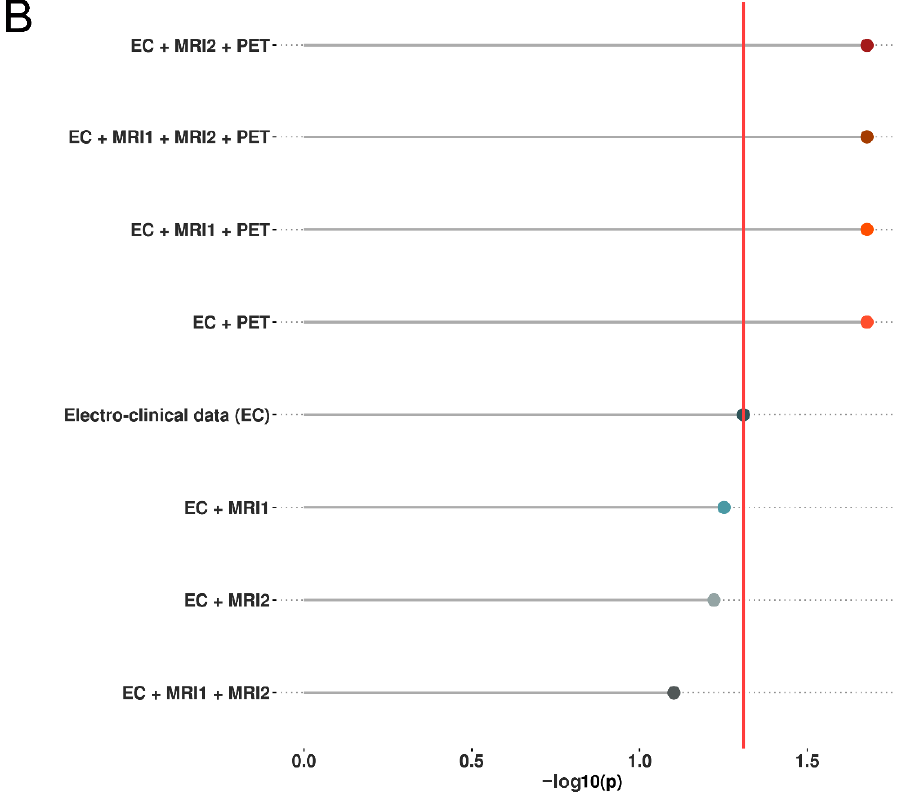
Figure 3. Clinical data concordance (CDC) of “Grouping Method 2.” Boxplots of the eight CDC parameters, depending on the two-way classified clinical decisions (CD2). ( A ) When the “operable” and “implantable” groups were integrated into the “invasive” group, only PET-related CDC variants were able to significantly differentiate between “invasive” and “inoperable” categories. ( B ) Analyzed by Mann–Whitney tests with FDR-correction, p -values are shown on the segments in the charts; Negative log10 transformed p values also confirmed the high relevance of PET-based measurements since the vertical line corresponding to p = 0.05 separates the non-significant and significant comparisons.